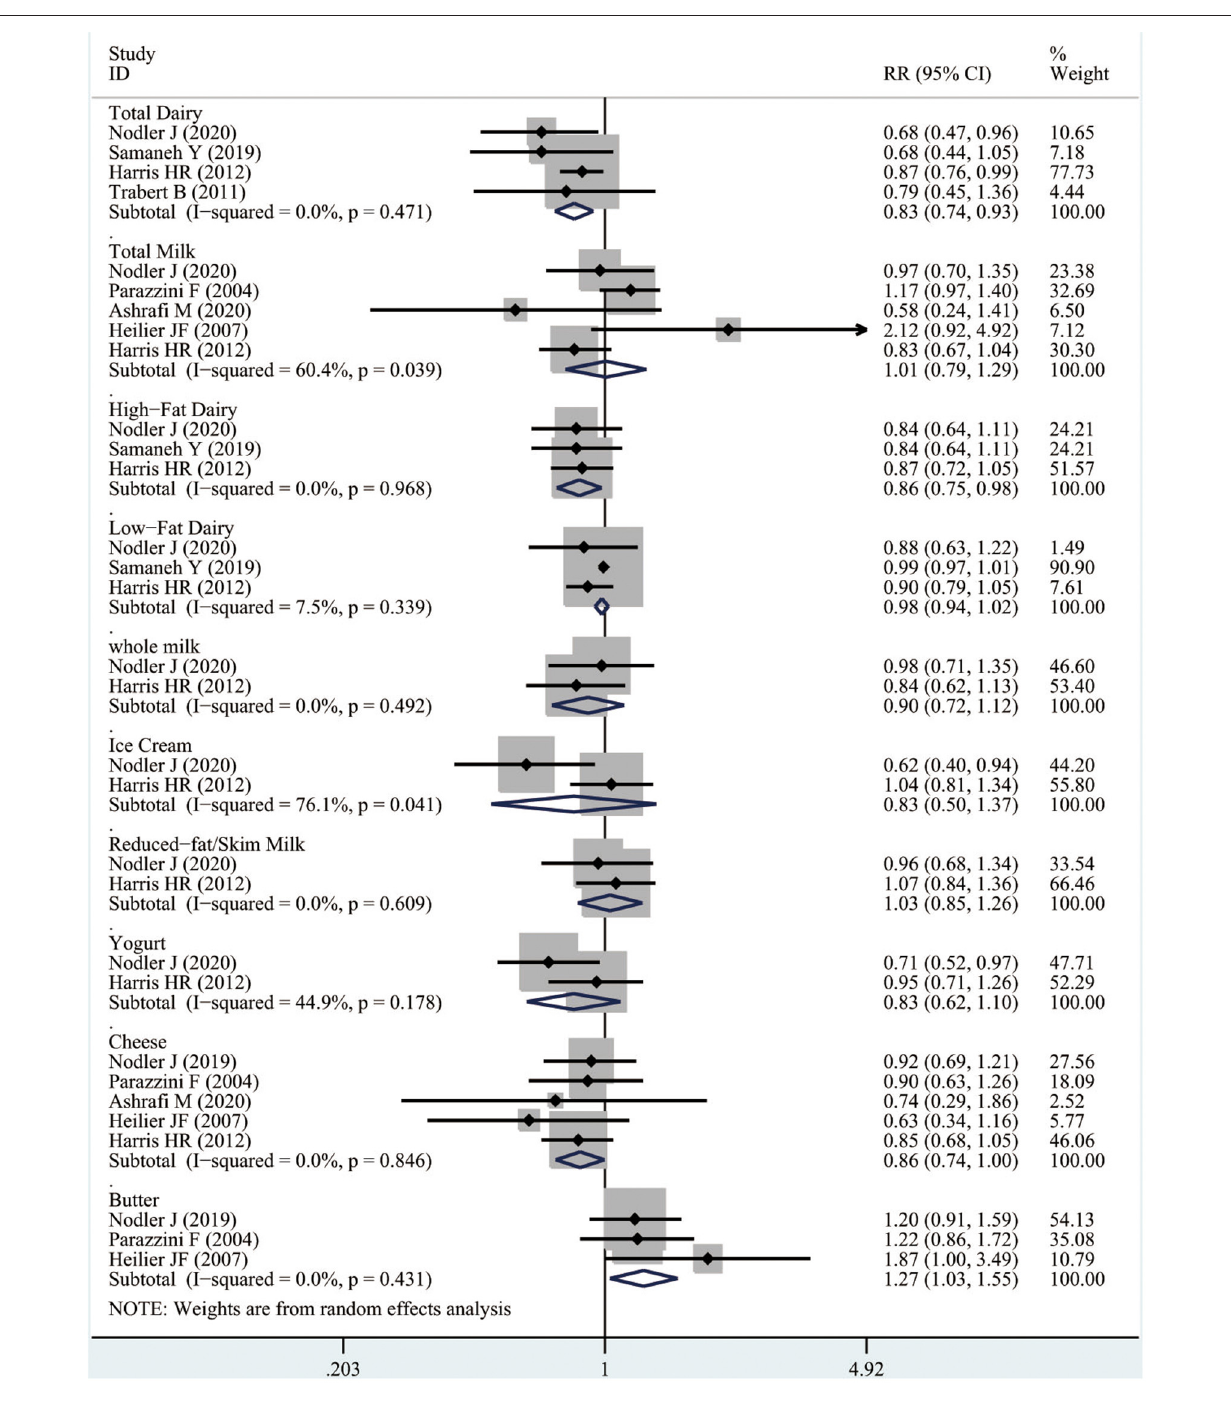
The pathogenesis of endometriosis remains